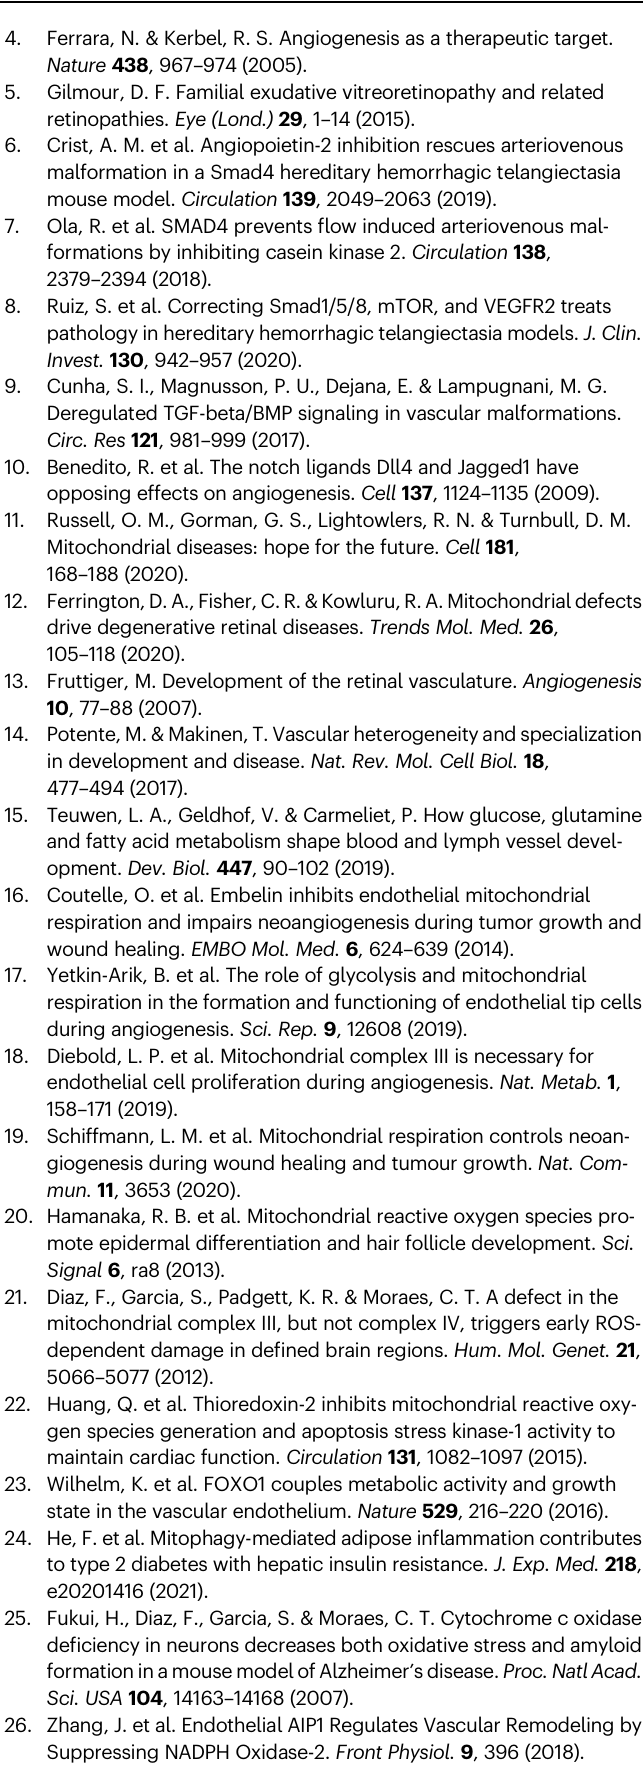
Table 2) of the positive differentially expressed genes for each cluster compared to all other cells. To identify differential expression genes between WT and the different mutants within ECs, the Seurat Find- Markers function was applied with the default parameter using a Wil- coxon Rank Sum test and excluding cells from clusters 8 and 9 which were identi fi ed as pericytes cells and neuron cells. Genes were con- sidered signi fi cantly differentially expressed when the adjusted p -value, based on Bonferroni correction using the total number of genes in the dataset, was below